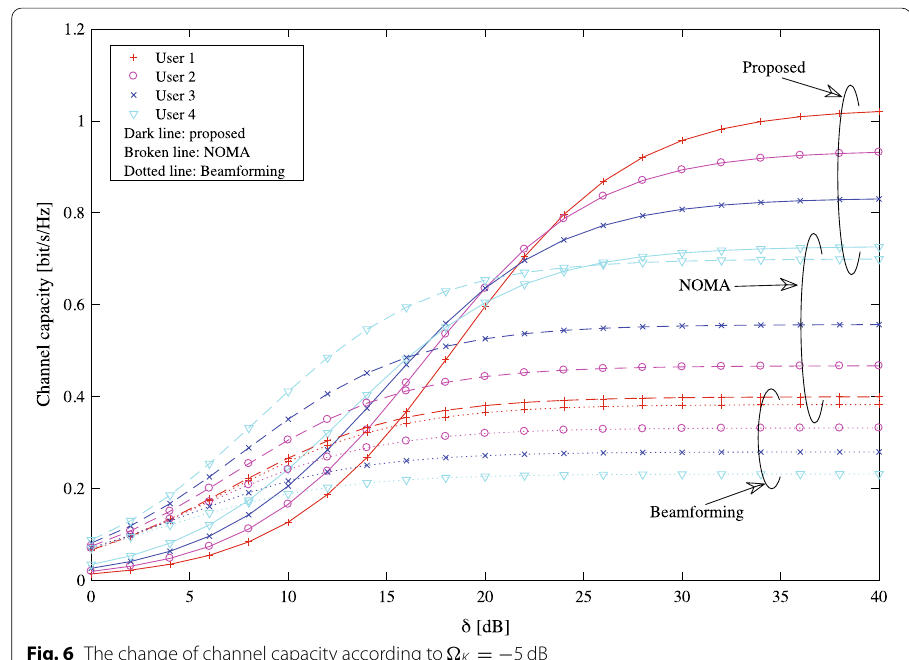
Fig. 6 The change of channel capacity according to (cid:31) K = − 5dB